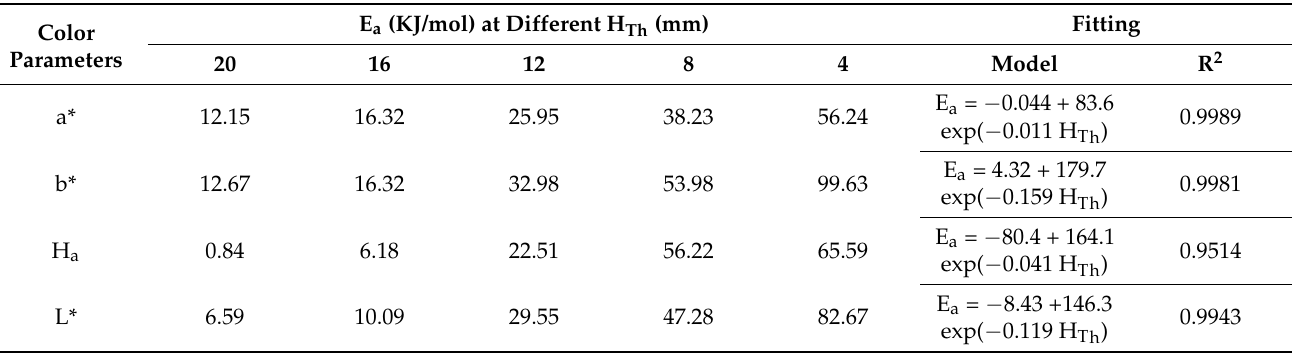
Table 3. The apparent activation energy required for color change in different thicknesses of green tea